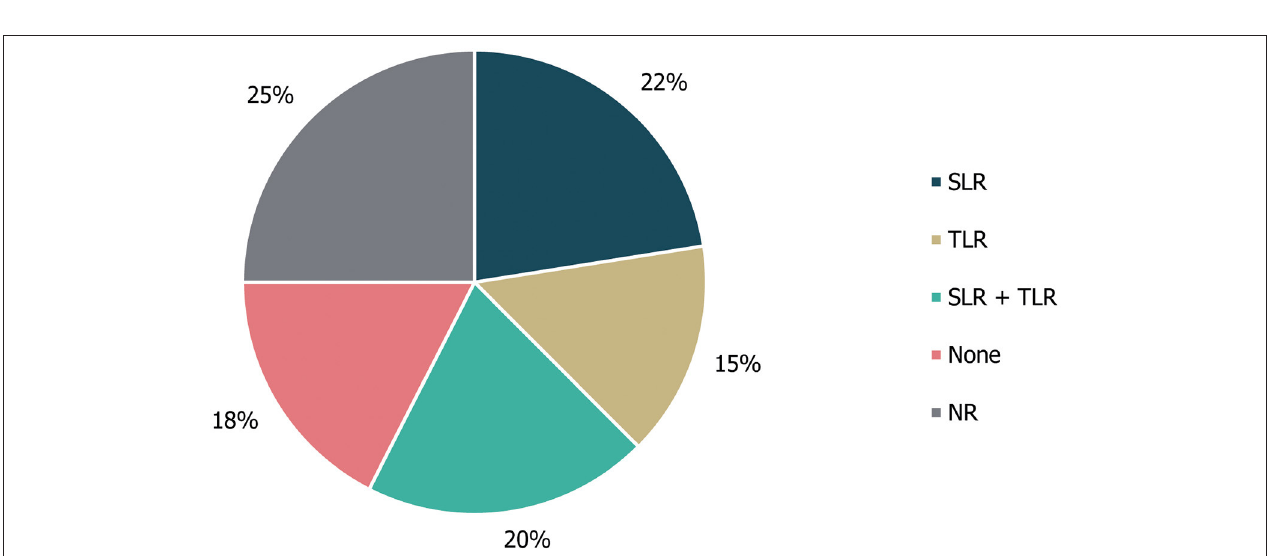
FIGURE 3 | Types of literature review performed to inform guideline development. “None” refers to guidelines in which a literature review was explicitly not used; NR, not reported; SLR, systematic literature review; TLR, targeted literature